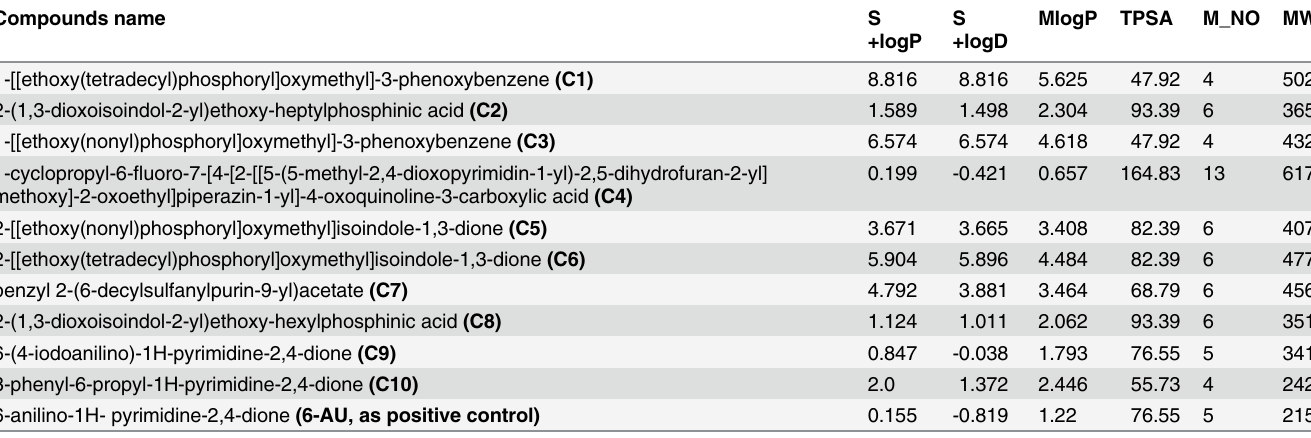
Table 3. ADMET analysis of top interactive compounds with Mtb DnaE2 comparative model. Compounds